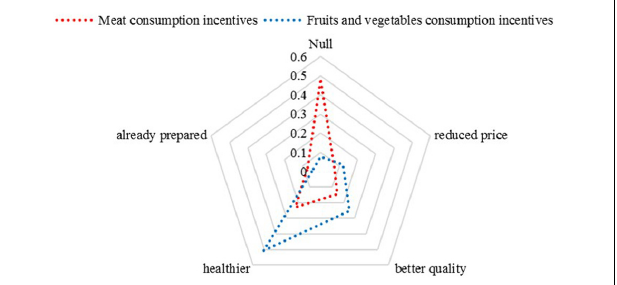
FIGURE 4 | Differences in options regarding the consumption and motivation in consumption of meat products and/or fruits and vegetables.